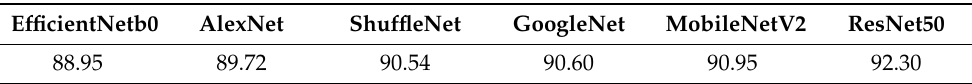
Figure 4. Layer update on pre-trained models. Table 2. Table 2. Table 2. Accuracy values of pre-trained models (%). Table 2. Accuracy values of pre-trained models (%).